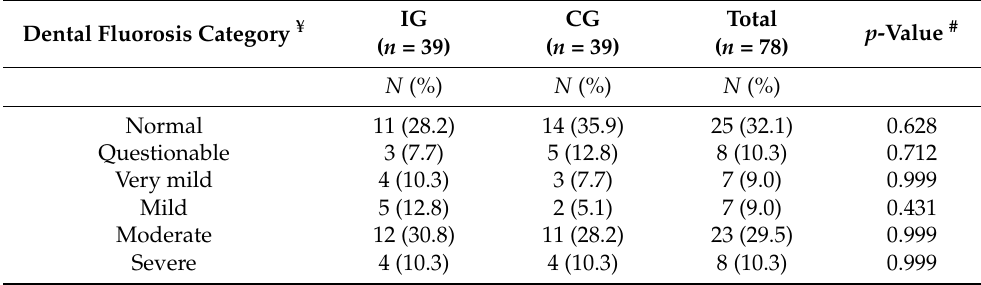
Table 2. Comparison of prevalence of dental fluorosis between the intervention and